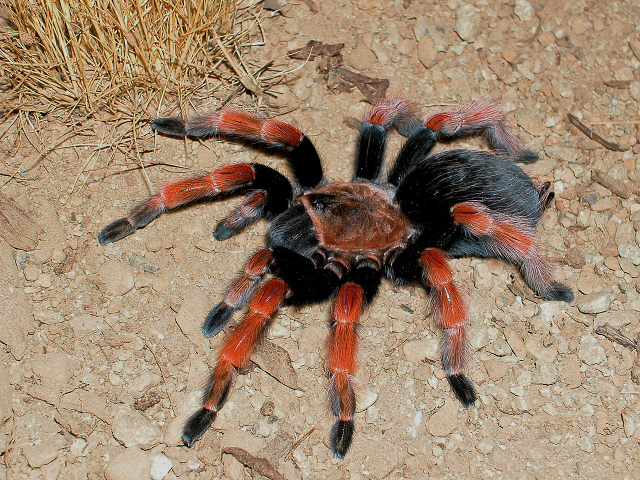
Brachypelma
boehmei Schmidt & Kraus 1993, female from north of Ixtapa, Guerrero state, Mexico. Photo: Rick C. West.